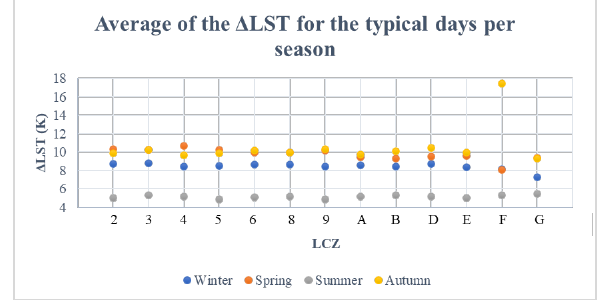
Figure 6 . Mean LST per LCZ and season from all MODIS data available.